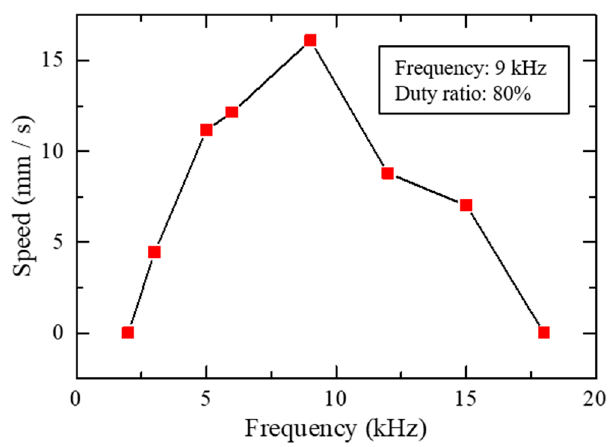
Figure 15. Driving characteristics of the slider 2 at different frequencies.